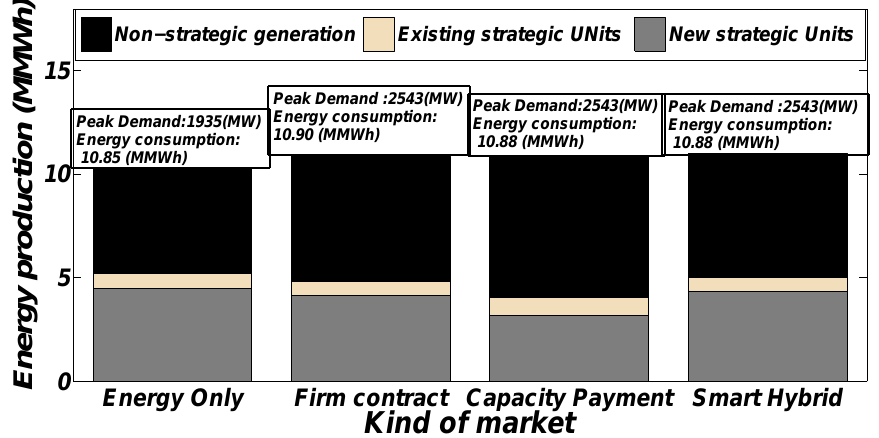
Figure 8. Total energy produced by units in different market